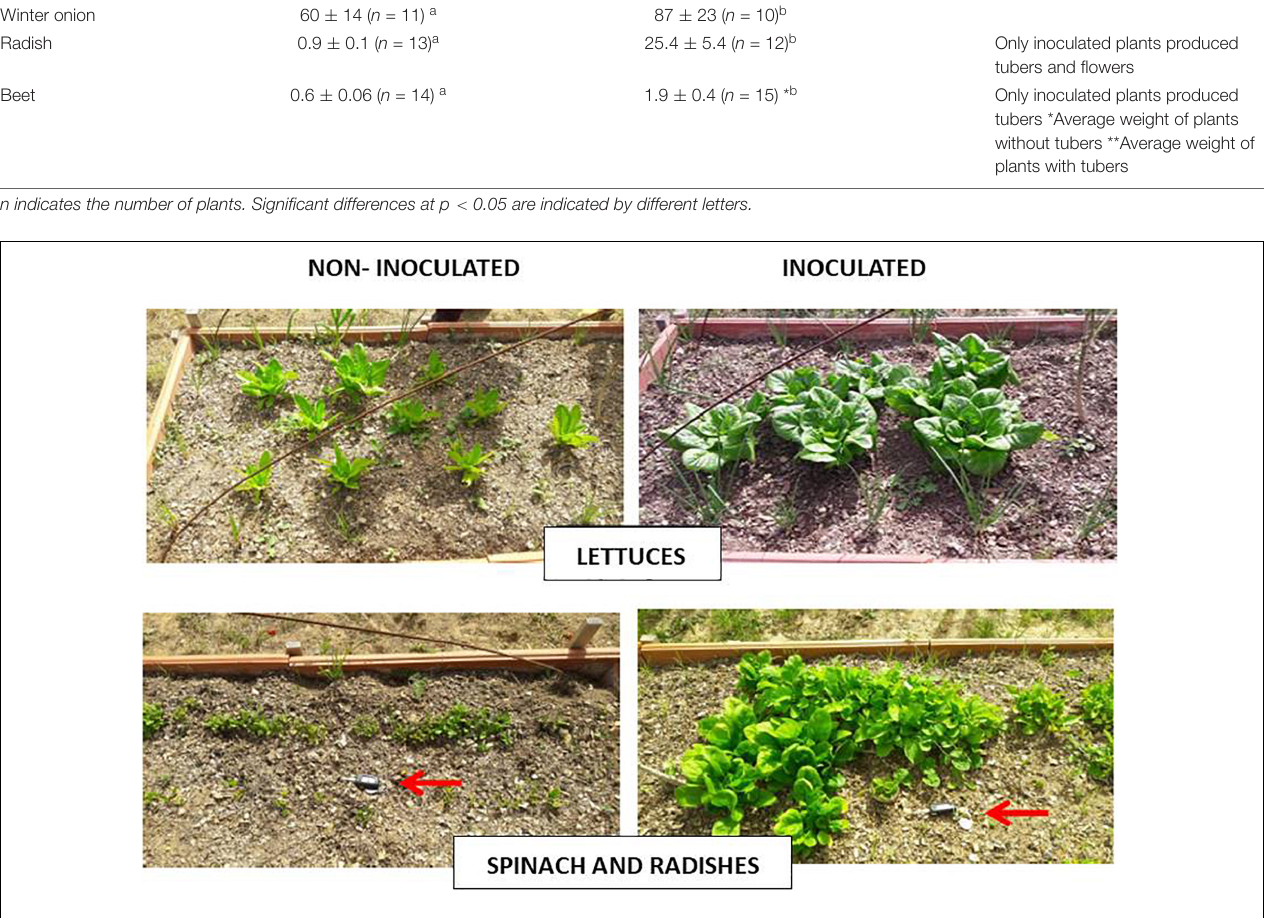
FIGURE 3 | Aspect of lettuces, spinach and radish plants in the orchard one month after planting. Left: non-inoculated; right: inoculated. The red arrow points a key used for size comparison. Values represent mean ± SE, n = 10 (for spinach and lettuces), and n = 50 (for